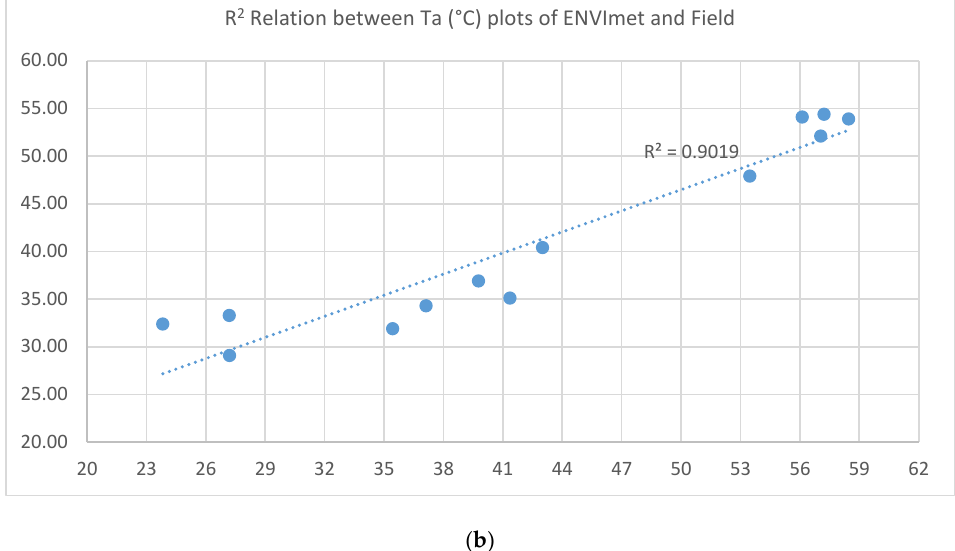
Figure 7. (a) Comparison between radiant temperature results of ENVI-met and Field measurements. (b). R 2 Relation between radiant temperature (°C) plots of ENVI-met and Field measurements.